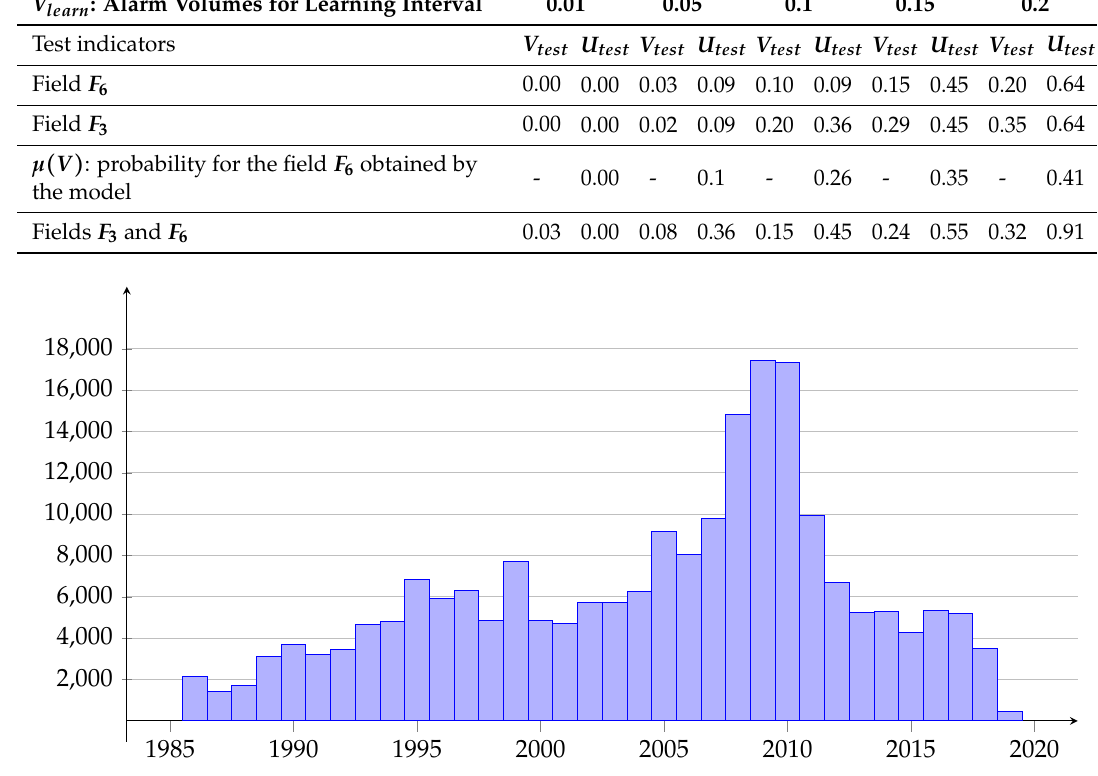
Figure 1. Histogram of the number of earthquakes with a magnitude greater than 2.7 and a depth of hypocenters less than 160 km.